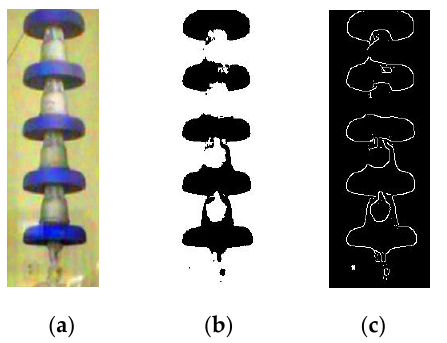
Figure 6. The comparison diagram of the original image and the binarization image and the image after edge detection processing. ( a ) Original image. ( b ) Binarization image. ( c ) Image after edge detection processing.